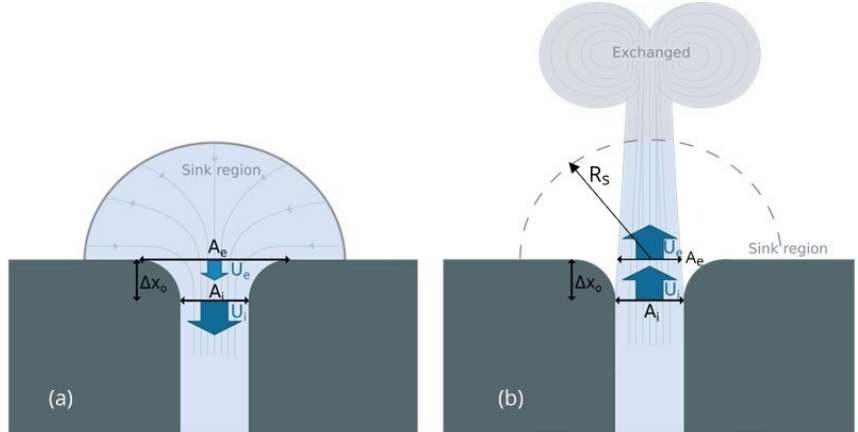
Figure 2. A sketch illustrating the flow asymmetry that leads to tidal pumping. The left panel (a) shows the tidal current entering the strait from all directions during ebb tide. The right panel (b) shows the tidal current exiting the same strait during flood tide; the flow now separates from the coastline and a dipole with a trailing jet forms and propagates away from the strait. U is the tidal current speed and A is the cross-sectional area. Subscripts “i” and “e” correspond to the inner and outer sides of the strait opening, respectively. (cid:49)x o is the length of the strait opening where we evaluate the flow asymmetry and the non-linearity of the flow dynamics. R s measures the effective size of the “sink region” from which waters enter the strait during